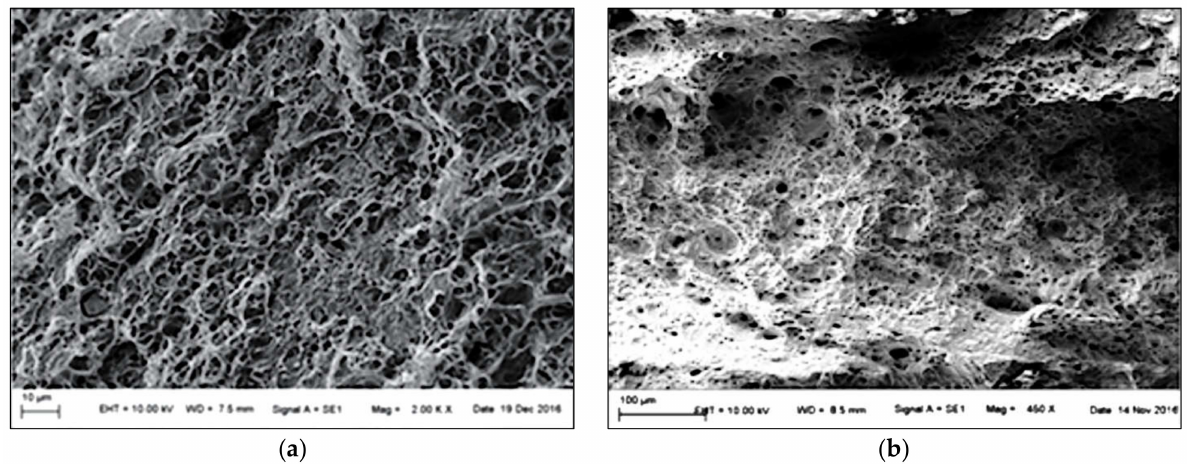
Figure 11. Fracture surface of the fusion zone: ( a ) under static loading 8.33 × 10 − 3 s − 1 , ( b ) under dynamic loading 1200 s − 1 .